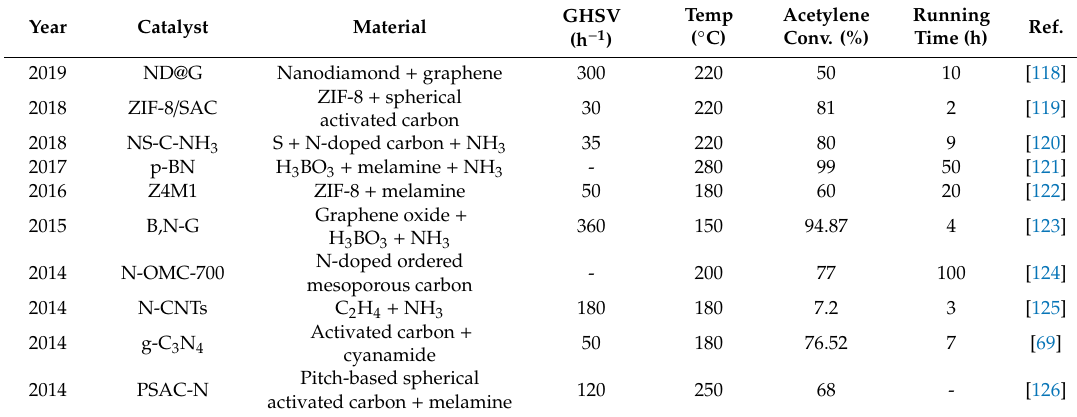
Table 6. Performance of carbon material catalysts for acetylene